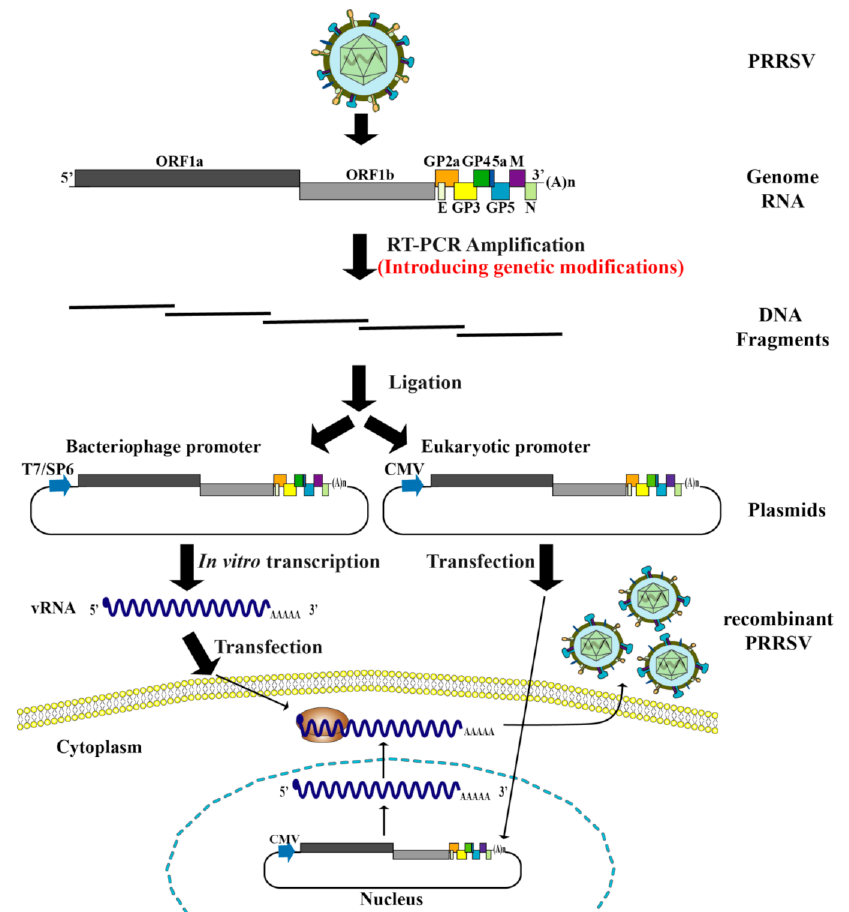
Figure 2. Schematic diagram of the construction of recombinant PRRSVs based on the reverse genetic system. PRRSV genomic RNA is extracted and reverse transcribed to produce cDNA. Several overlapping fragments amplified from the PRRSV genome are ligated with each other and a linearized bacterial plasmid according to homologous recombination technology. During the fragment amplification process, mutations are introduced to generate the full-length infectious cDNA clones with genetic modification. The cDNA cloned downstream of a phage-derived T7 or SP6 promoter is transcribed in vitro, and the transcribed RNA is transfected into cells to initiate infection cycles; or the cDNA cloned into the downstream of a eukaryotic promoter (CMV) is transfected into cells to rescue the recombinant